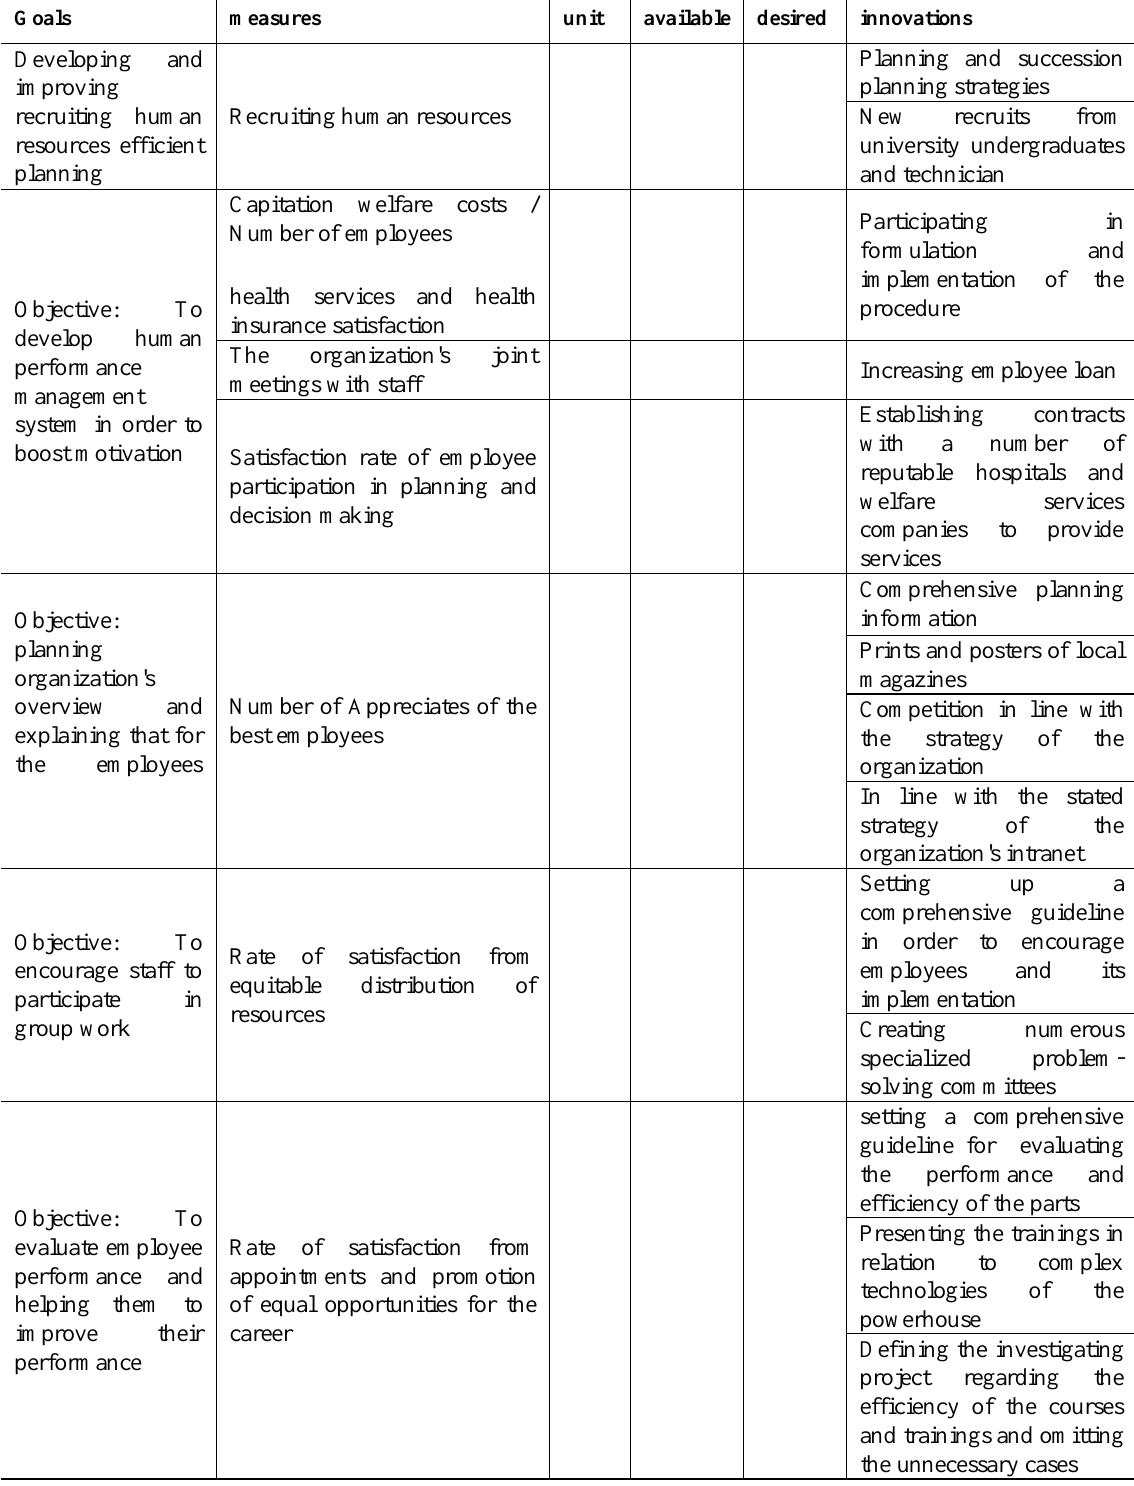
Table 4. Evaluated BSC from a learning and growth perspective Learning and Growth perspective (for the realization of our overview, we must build the ability to change and